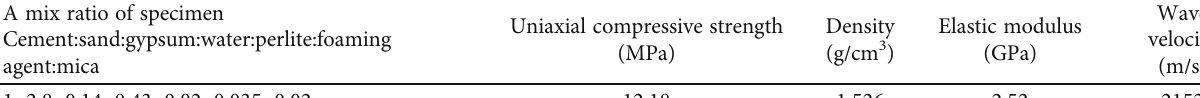
Table 2: Mix ratio and mechanical properties of simulated coal.